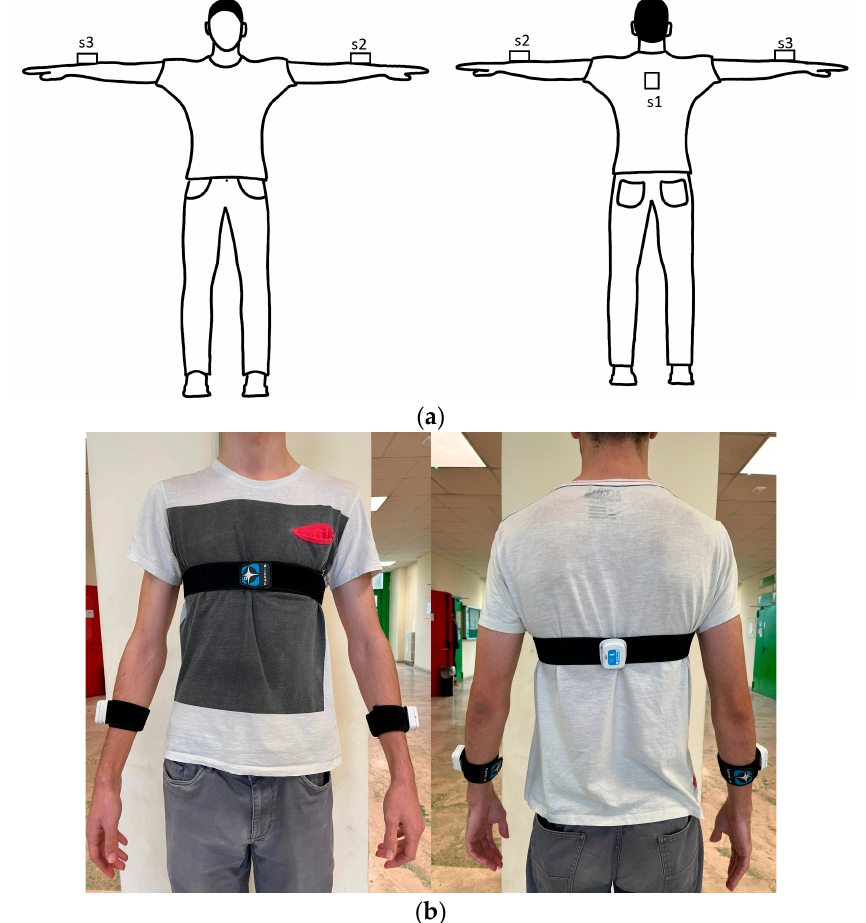
Figure 1. Wearable sensors as placed on the subject’s body (( a ) scheme, ( b ) real), s1 on the upper shoulder, s2 and s3 on the forearms.